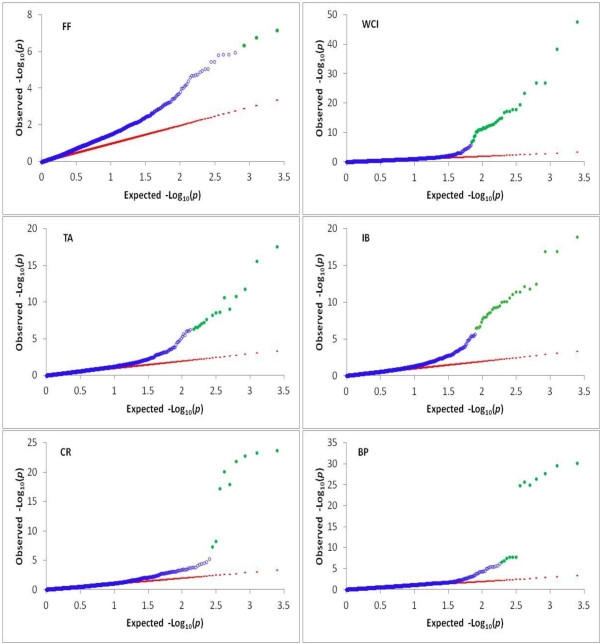
Quantile-quantile plot of the observed and expected –log10(p) values for various traits (FF: fruit firmness; WCI: weighted cortical intensity; BR: internal browning; TA: titratable acidity; CR: fruit splitting; BP: bitter pit) from a genome-wide scan. The values exceeding the genome-wide significance threshold are highlighted in green colour.